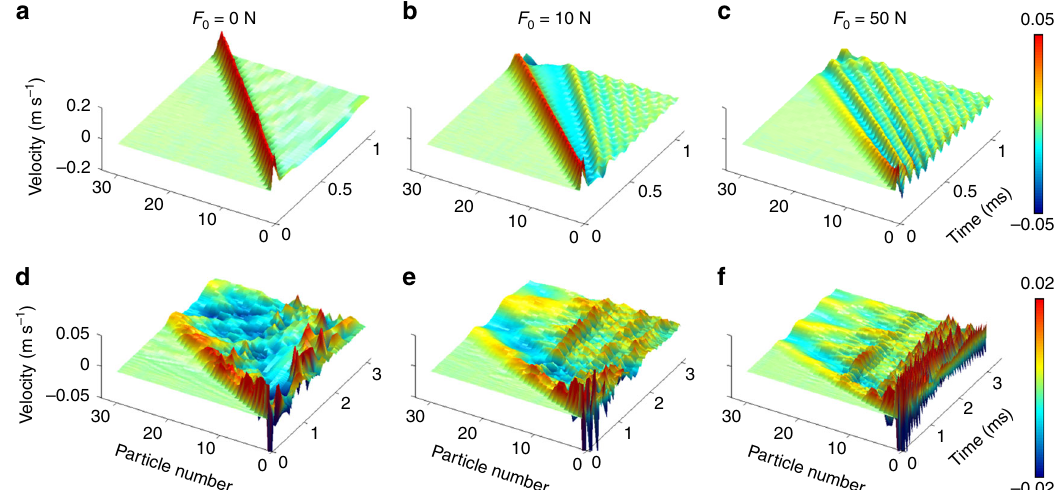
Fig. 2 Wave propagation in homogeneous and disordered chains. Spatiotemporal distributions of particle velocities in ( a – c ) a homogeneous chain and ( d – f ) a disordered chain with static precompressions of ( a , d ) 0 N, ( b , e ) 10 N, and ( c , f ) 50